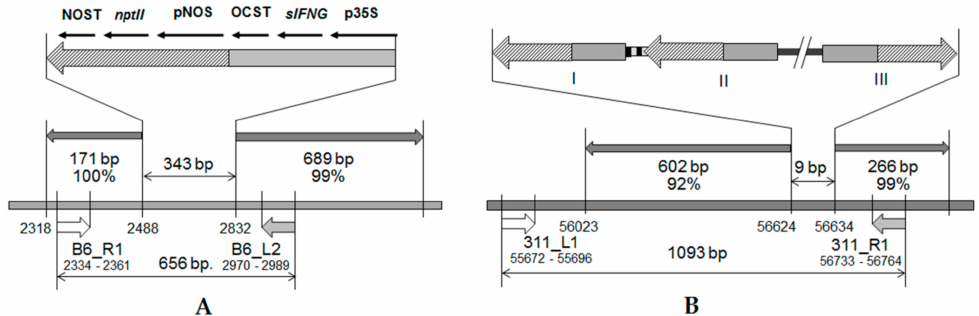
Figure 4. T-DNA insert structures. The figure shows the location of the sequences obtained as a result of genome walking, the length of the overlapping regions, and the percentage of similarity are indicated. The binding sites of the primers used to confirm the genome walking data, and the length of the resulting PCR fragment are also indicated. ( A ): Insert structure from line B6 (into sequence NW_015800096.1). ( B ): Insert structure from line 311 (into sequence NW_015801991.1). Numbers I, II, III denote copies of